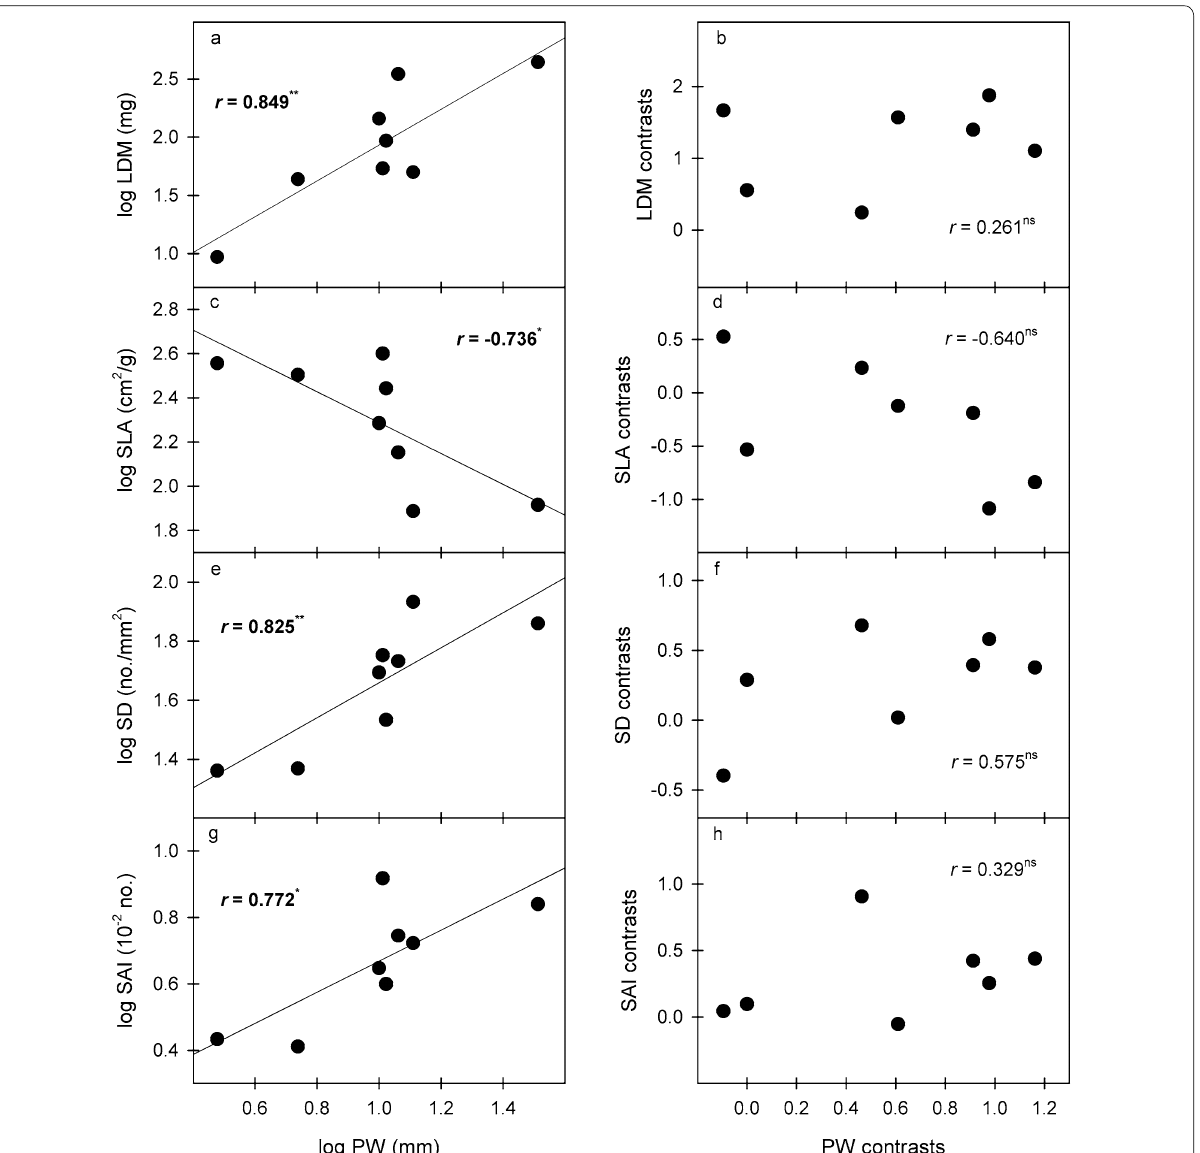
Fig. 4 Significant correlations of species mean values and PICs between pseudobulb width (PW) and leaf traits. * p < 0.05; ** p < 0.01. LDM leaf dry mass, SLA specific leaf area, SD stomatal density, SAI stomatal area